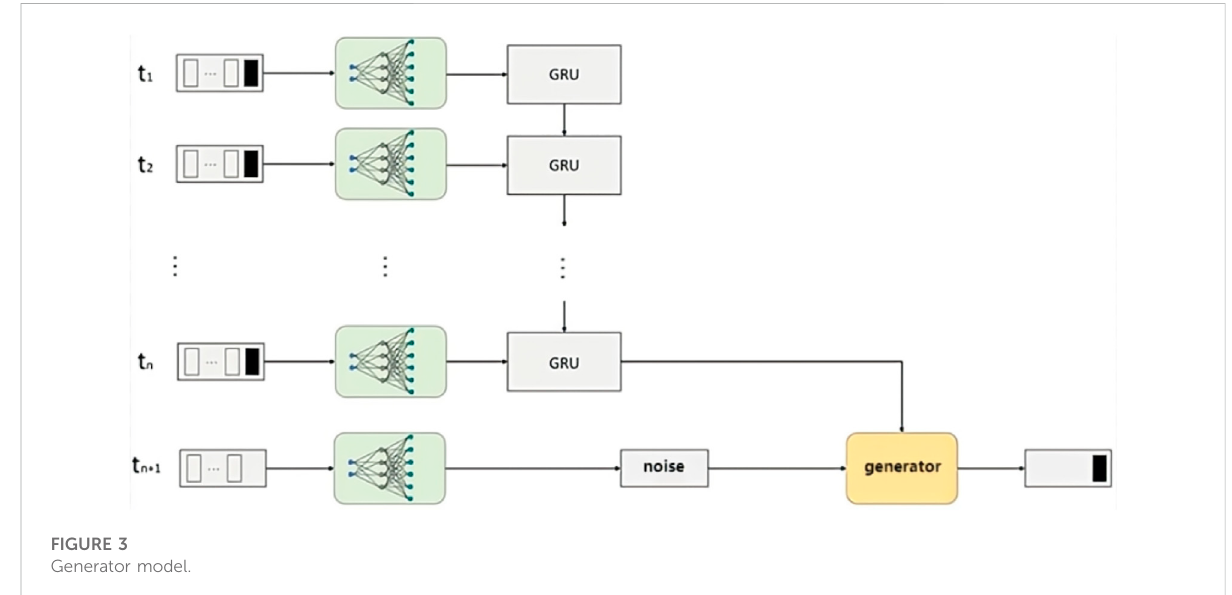
FIGURE 3 Generator